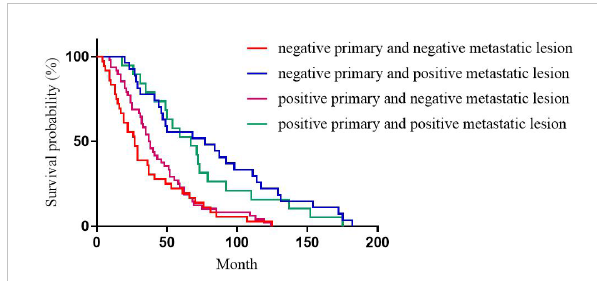
FIGURE 2 Correlation between PR expression heterogeneity and patient